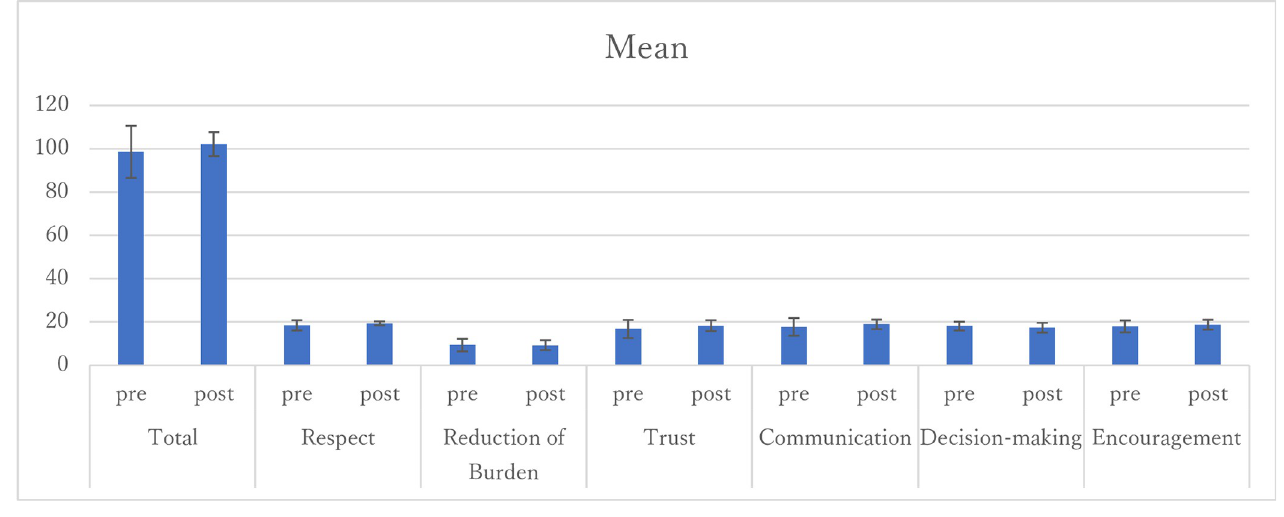
Fig 4. Means of WCC23E, pre- and post-intervention.